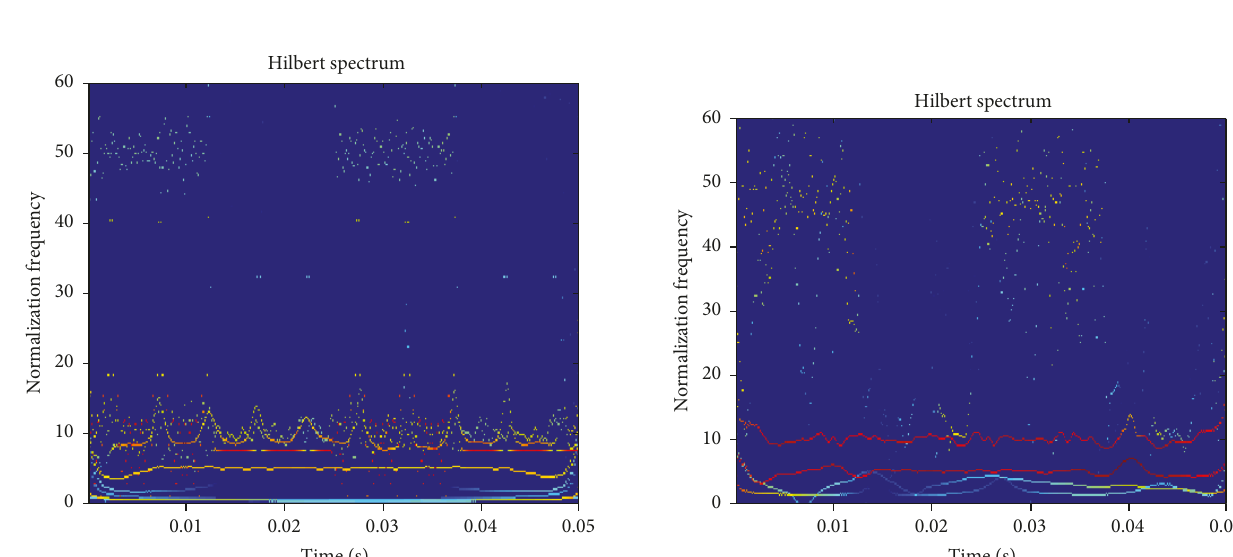
Figure 7: Hilbert spectrum of EEMD. Figure 8: Hilbert spectrum of CEMD.